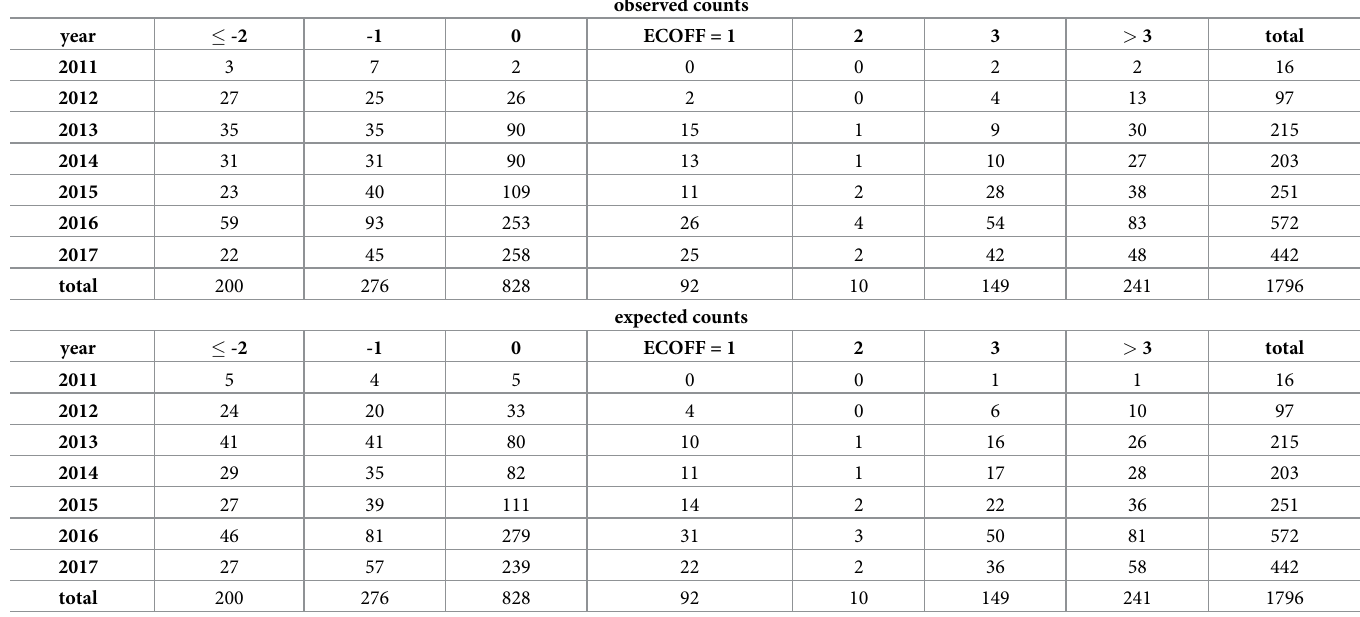
Table 6. The ISU VDL data. The upper table: observed counts for each year. Lower table: based on the best fitting model 7, the expected counts for each year, given the observed total for each year.